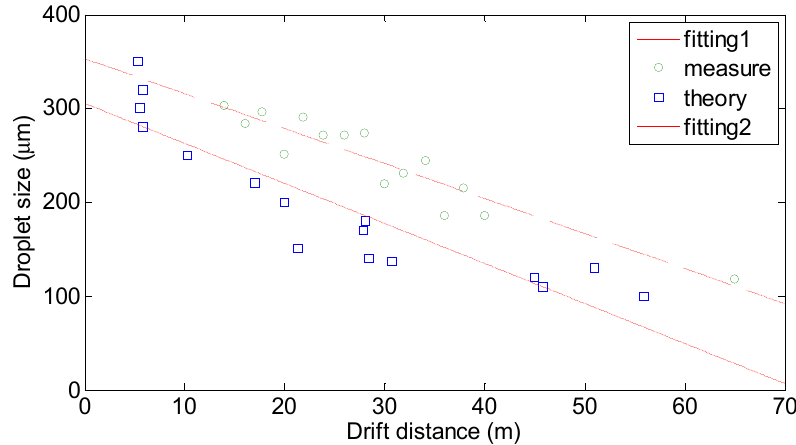
Figure 22. Relation between droplet size and drift distance compared to theory and measure of field experiment, “fitting1” and “fitting2” refer to the linear regression of data obtained by measure (field experiment) and theory, respectively.